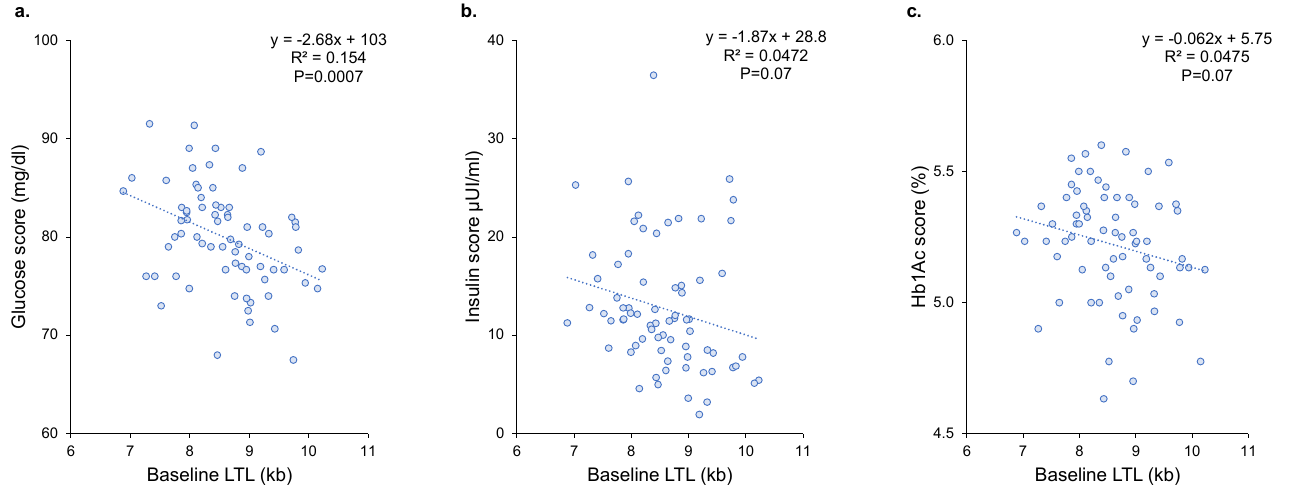
Figure 4. Relationships between baseline LTL and glucose ( a ), insulin ( b ), and Hb1Ac ( c ) scores. R 2 and p are from Pearson’s correlation. LTL = leukocyte telomere length; kb = kilobase. Table 3. Multivariate models analyzing the effects of LTL and covariates on diabetes scores.